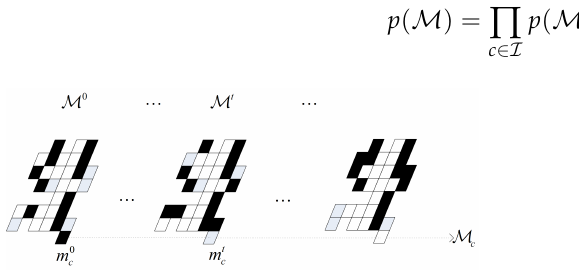
Figure 3. An example of a map